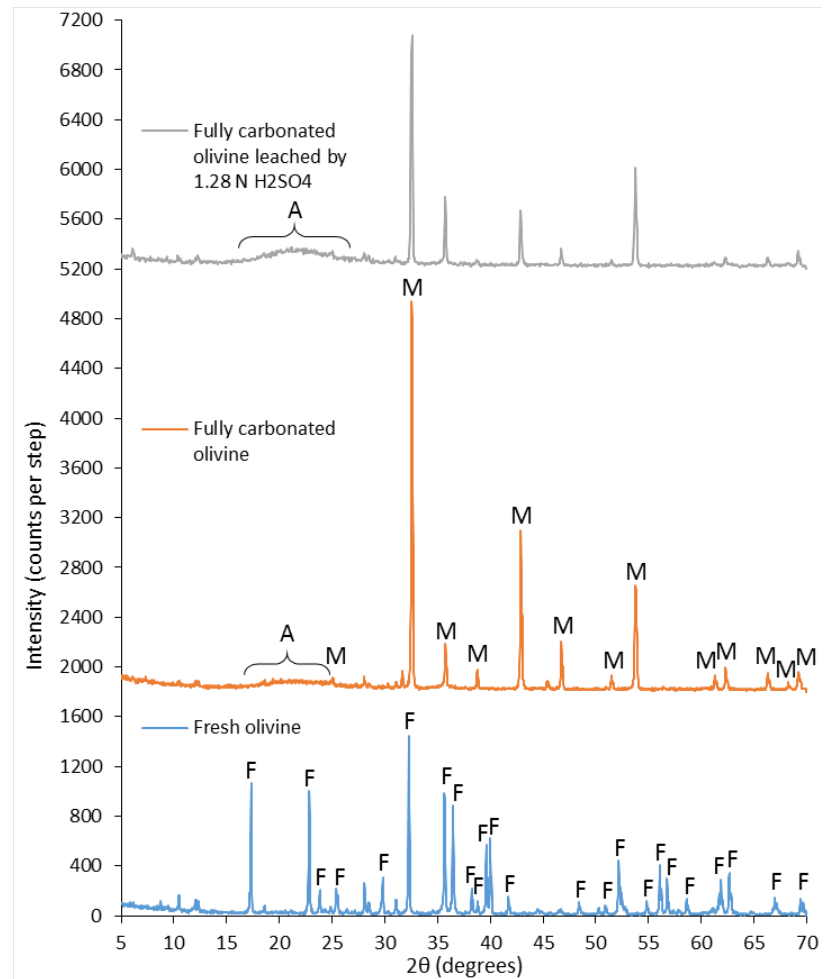
Figure 1. XRD diffractograms of fresh olivine, fully carbonated olivine and fully carbonated olivine after leaching in 1.28 N H 2 SO 4 for 24 h; major mineral peaks are